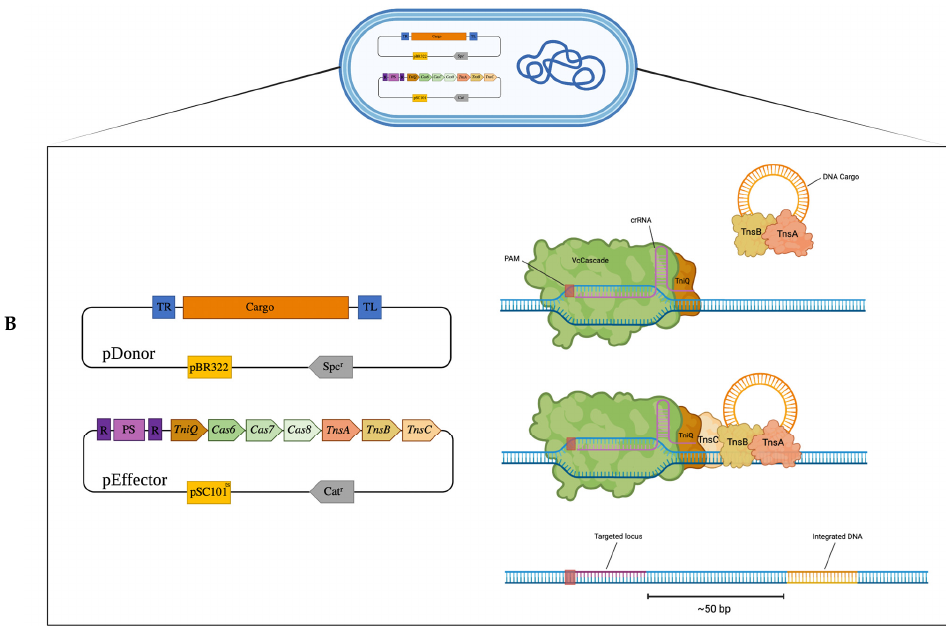
Figure 1. Schematic representation of the two-plasmid system for genomic integration via transposon- associated CRISPR-Cas system. ( A ) CRISPR-Cas9 coupled with λ Red recombineering mechanism: The guide RNA (gRNA) comprised of a protospacer (PS), Cas9-binding hairpin (CBH) and transcriptional terminator (ter), directs the Cas9 to the desired locus by recognizing the PAM sequence and the Cas9 cleaves the DNA through double strand breaks. Exo (lambda exonuclease) generates single-stranded 3 ′ overhangs and Beta proteins mediate annealing of the homology arms (HA) to the complementary DNA target in the genome. ( B ) Transposition mechanism: pEffector plasmid harboring the crRNA, VcCascade and transposition machinery. The CRISPR array com- prises two repeats (R) and a protospacer (PS) presented in violet. VcCascade consists of Cas6, Cas7 and Cas8 protein subunits presented in green. The transposition machinery comprises TniQ subunit and transposition proteins TnsA, TnsB and TnsC presented in orange. pDonor plasmid harboring a DNA cargo, i.e., bktB : phaB (2.2 kbp), phaC : phaA (3.3 kbp) or cas9 (5.5 kbp), flanked by transposon right- (TR) and left- (TL) end sequences. The crRNA which is principally responsible for the PAM site recognition and R-loop formation, binds to the VcCascade. The TniQ homodimer is bound to the VcCascade to form the VcCascade-crRNA-TniQ complex. To insert the DNA cargo in the desired genomic site, the crRNA directs the VcCascade-crRNA-TniQ complex to the desired locus, TniQ communicates with TnsC, and TnsC mediates the transposition by employing TnsAB to excise the DNA from its pDonor through double strand breaks, recognizing and binding to the TL and TR end sequences of the DNA cassette and integrates the DNA approximately 50 bp downstream of the targeted locus.